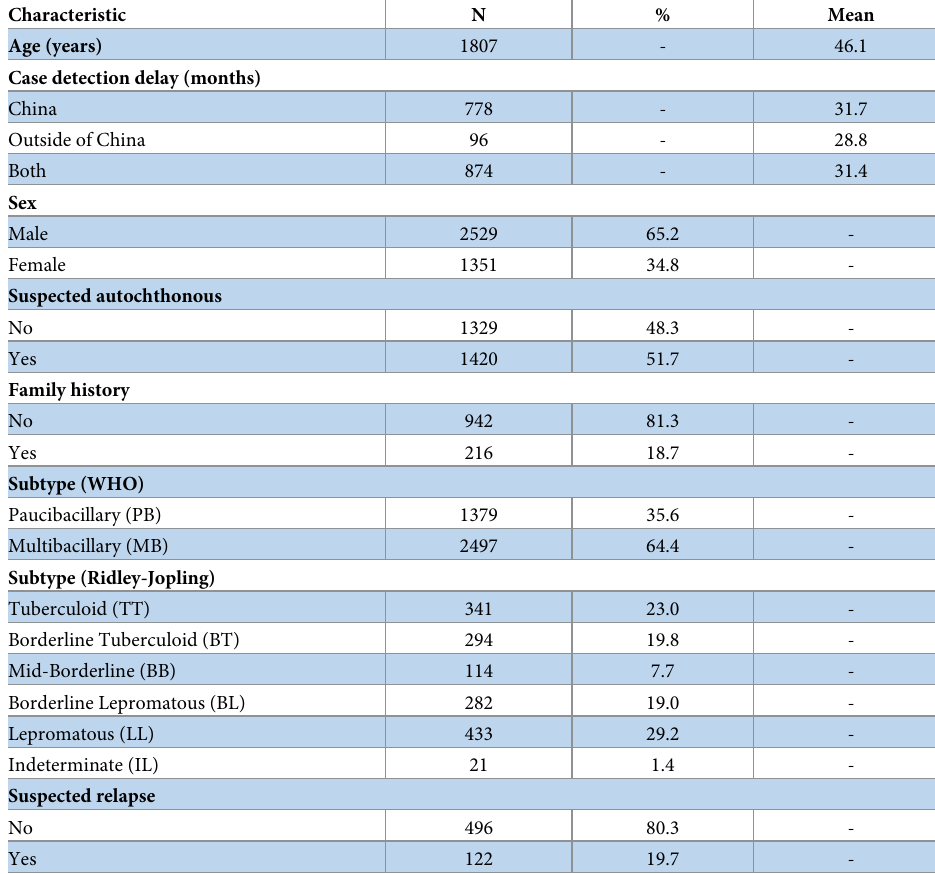
Table 4. Overview of case characteristics using combined individual leprosy case data.